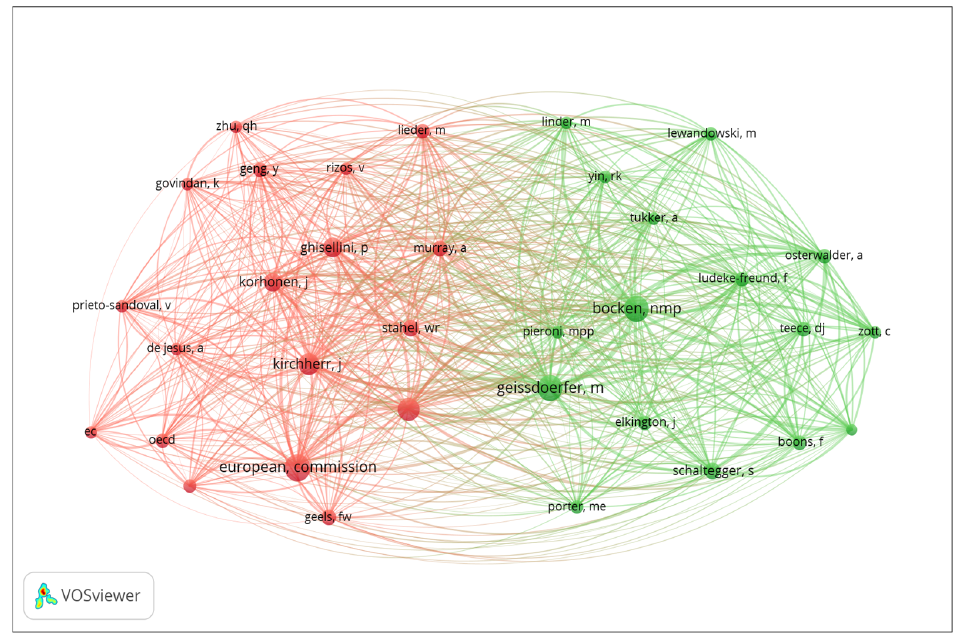
Figure 9. VOSviewer diagram containing the most cited authors with a minimum of 40 citations, for the couple: social innovation and circular*.